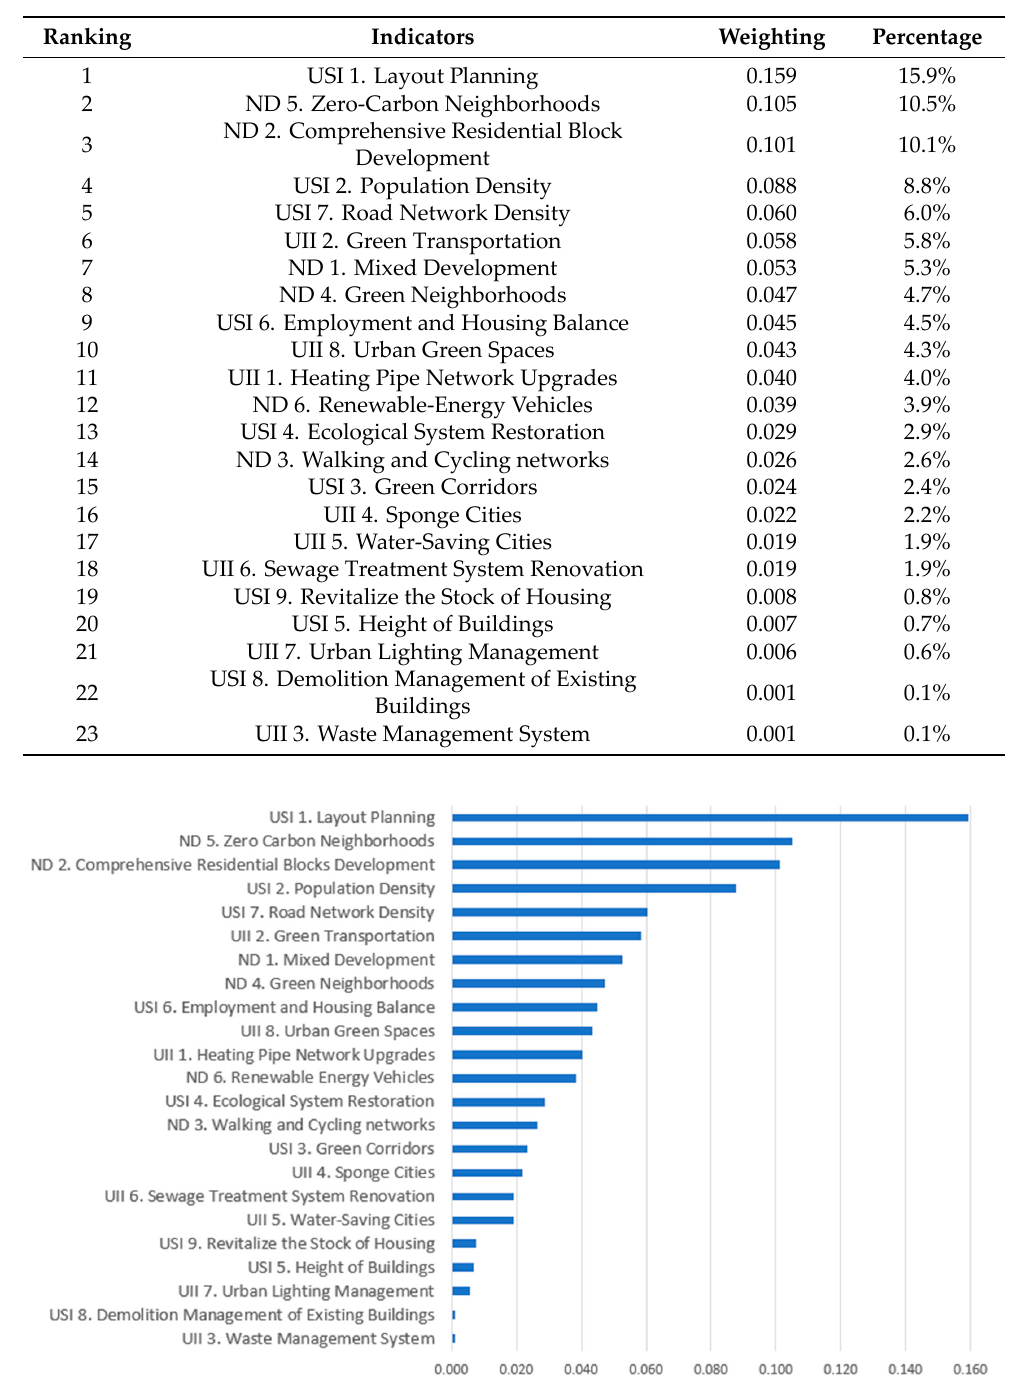
Table 8. Priorities and weighting of indicators.